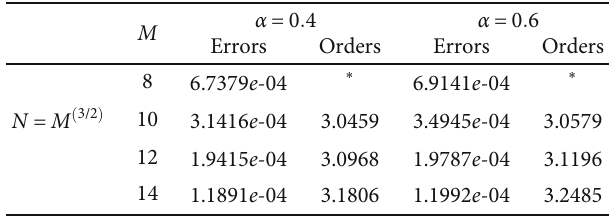
Table 3: The errors and convergence orders in spatial direction by using Q-FEM.